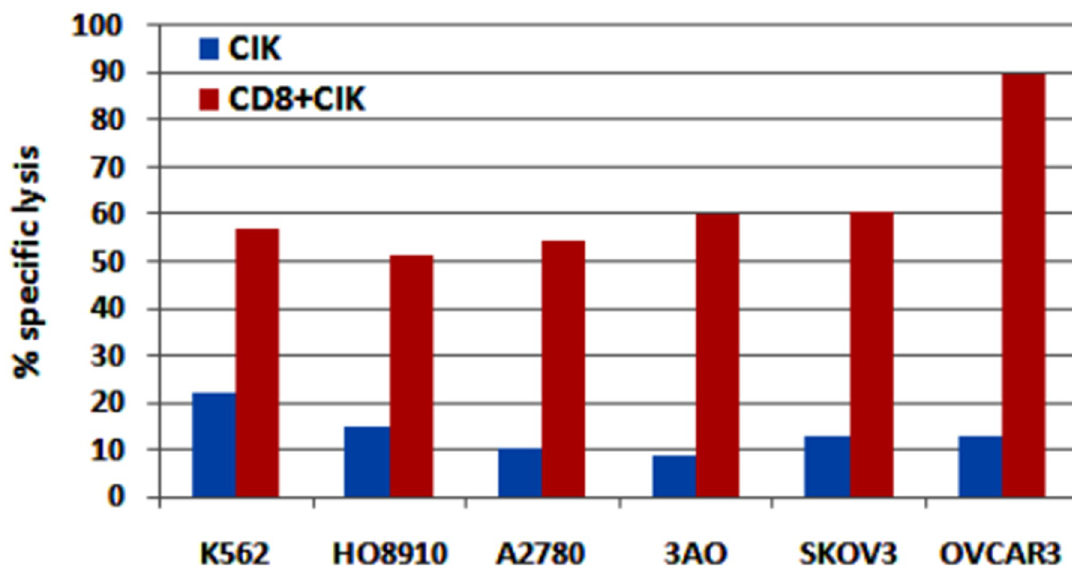
Fig 7. The cell killing activity of CIK cells and CD8+ CIK cells against ovarian cancer cells as analyzed by flow cytometry. The indicatedovarian cancer cells co-cultured with CIK cells or CD8+ CIK cells (1:10) for 4h. Cell death was analyzedwith PI and CFSE stainingcoupledwith flow